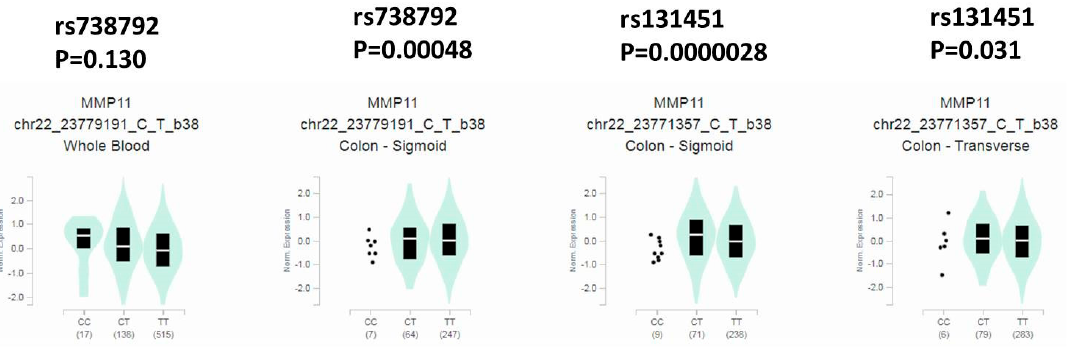
Figure 2. Distribution of MMP-11 expression in whole blood and colon (sigmoid, transverse) of MMP-11 SNPs rs738792, rs131451 from Genotype-Tissue Expression (GTEx) database.